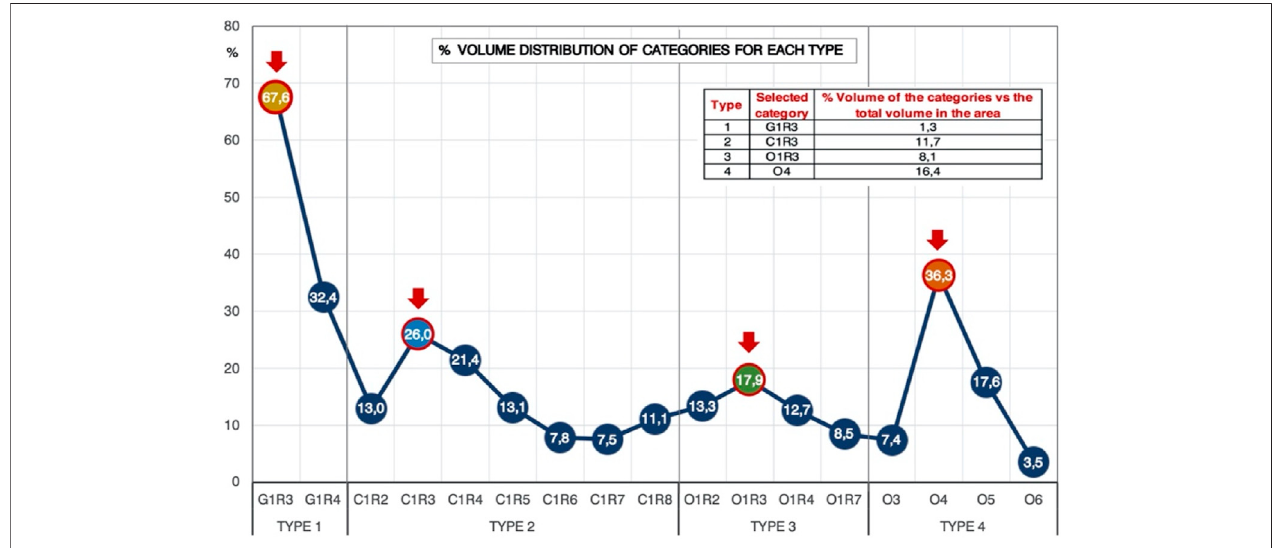
FIGURE 6 | Percentage volume distribution of categories and selected category for each type. The table shows the contribution of the selected categories to the total volume of buildings in the area.